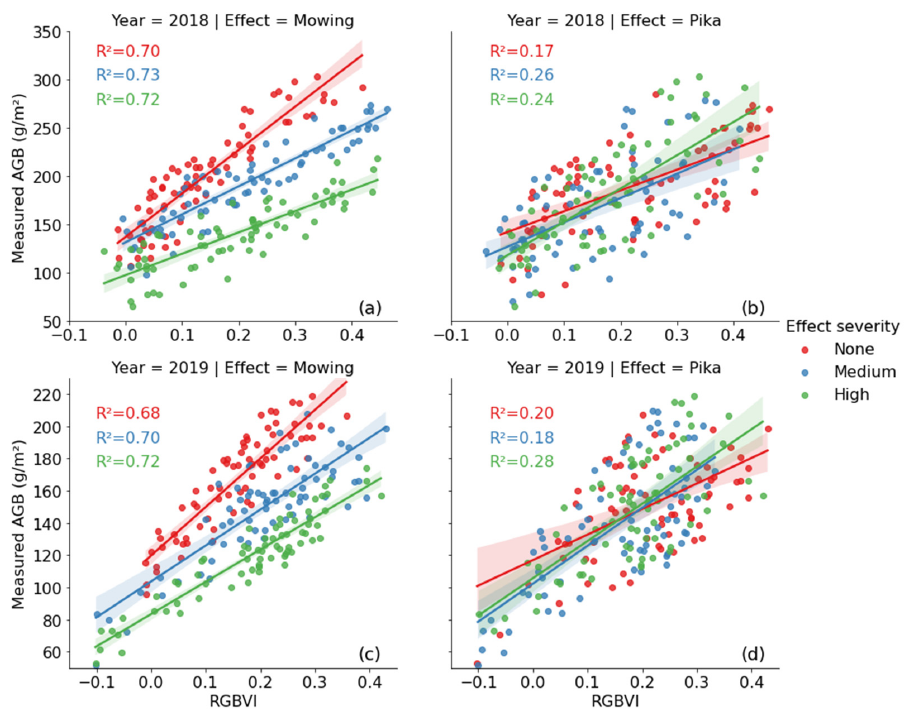
Figure 5. RGBVI value of sampled quarter and extracted bare ground: ( a ) the year of 2018; ( b ) the year of 2019.